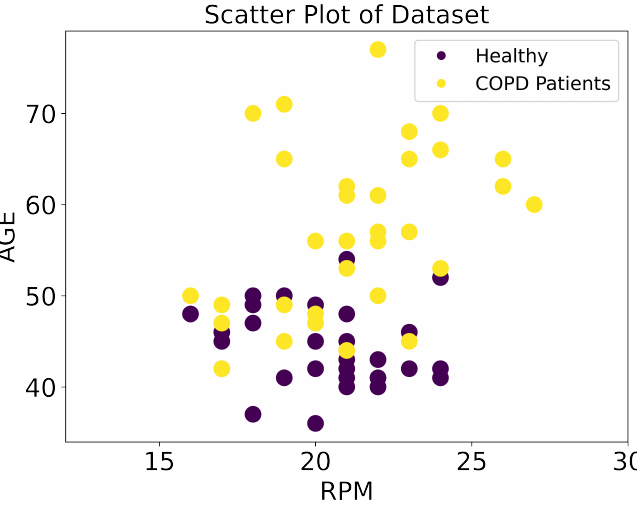
Figure 6. Features Visualization (0) represent Healthy, (1) represent COPD ( a ) RPM, Smoker, Age,